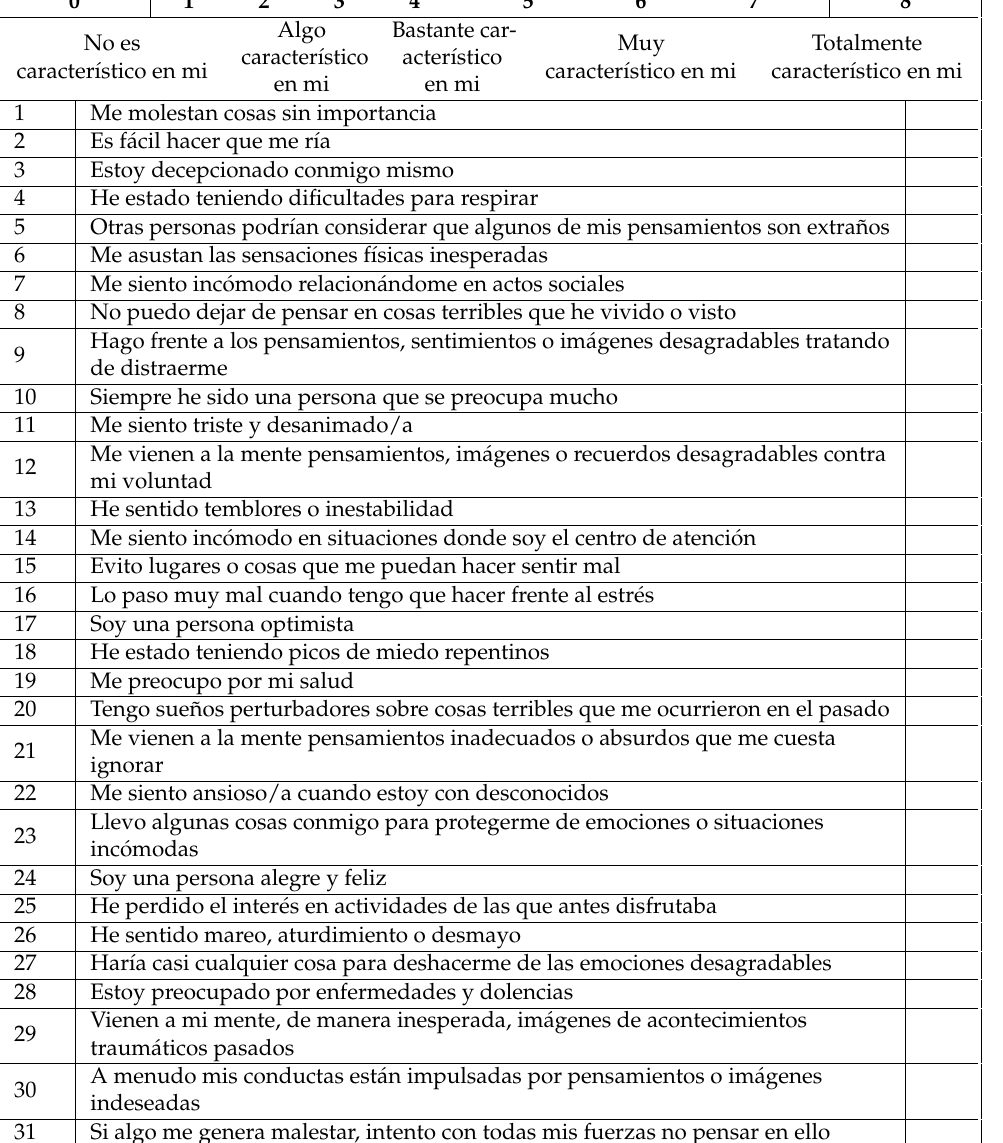
Table A1. Inventario Multidimensional de Trastornos Emocionales